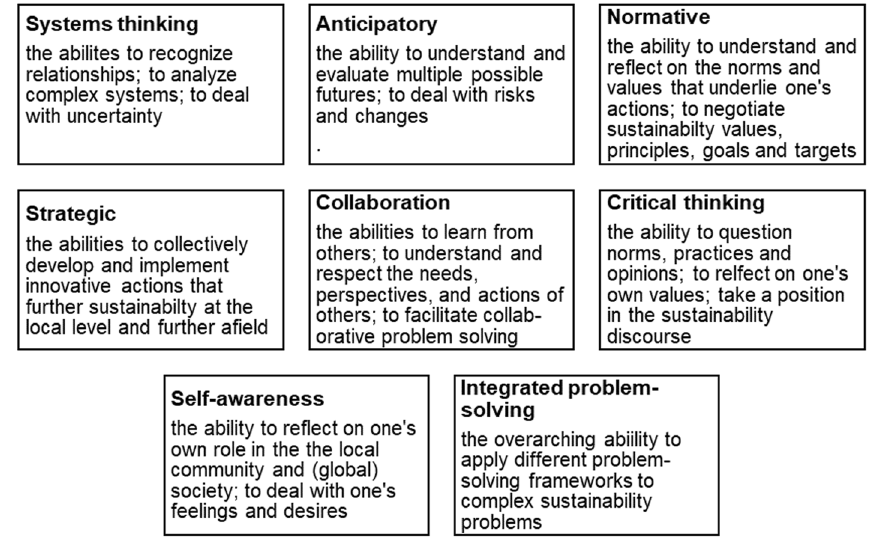
Fig. 1 Key competencies for sustainability (abbreviated). Source: ([6], p. 10)